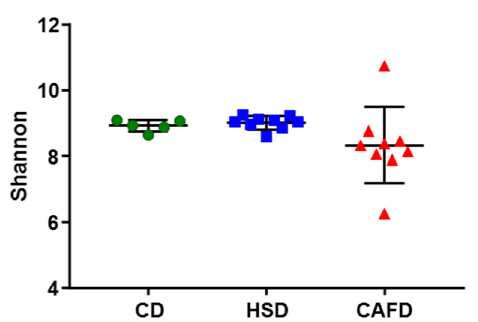
Figure 4. Comparisons of Shannon diversity values.